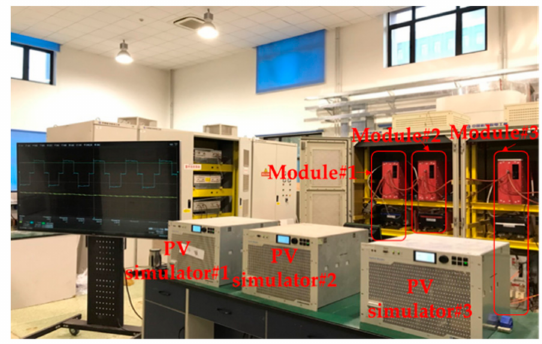
Figure 21. A prototype for the PV series DC system.